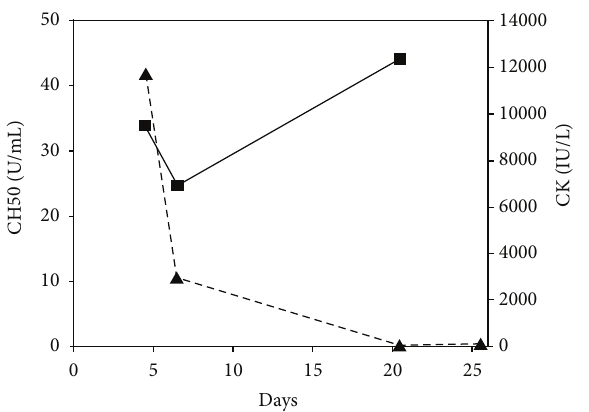
Figure 1: Clinical course of creatine kinase (CK) and CH50. The values of CK ( 󳵳 ) and CH50 ( ◼ ) are indicated in the right and left axes,